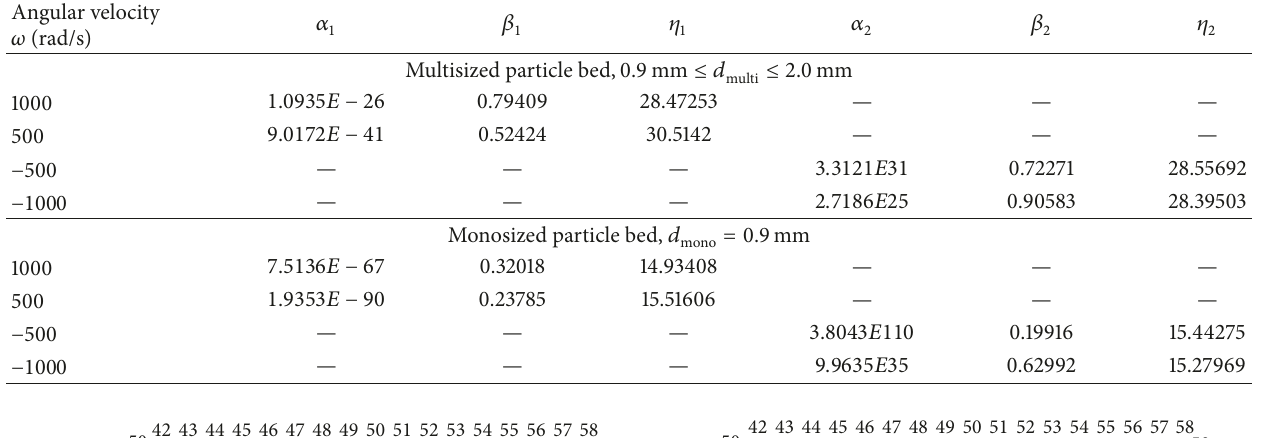
Angular velocity 𝜔 (rad/s)